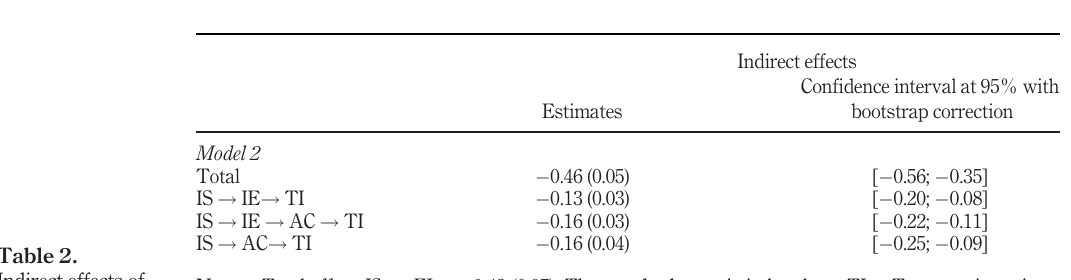
Figure 3. Model 1 ( H4a )